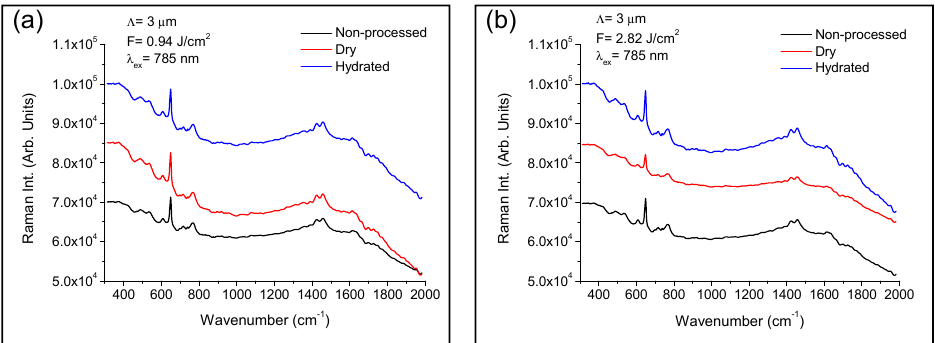
Figure 7. Micro-Raman spectra of the polymer sample in non-processed areas and in the DLIP structured regions with a spatial period of 3 µm at 0.94 J/cm 2 laser fluence ( a ) and 2.82 J/cm 2 laser fluence ( b ) before and after hydration assessment.